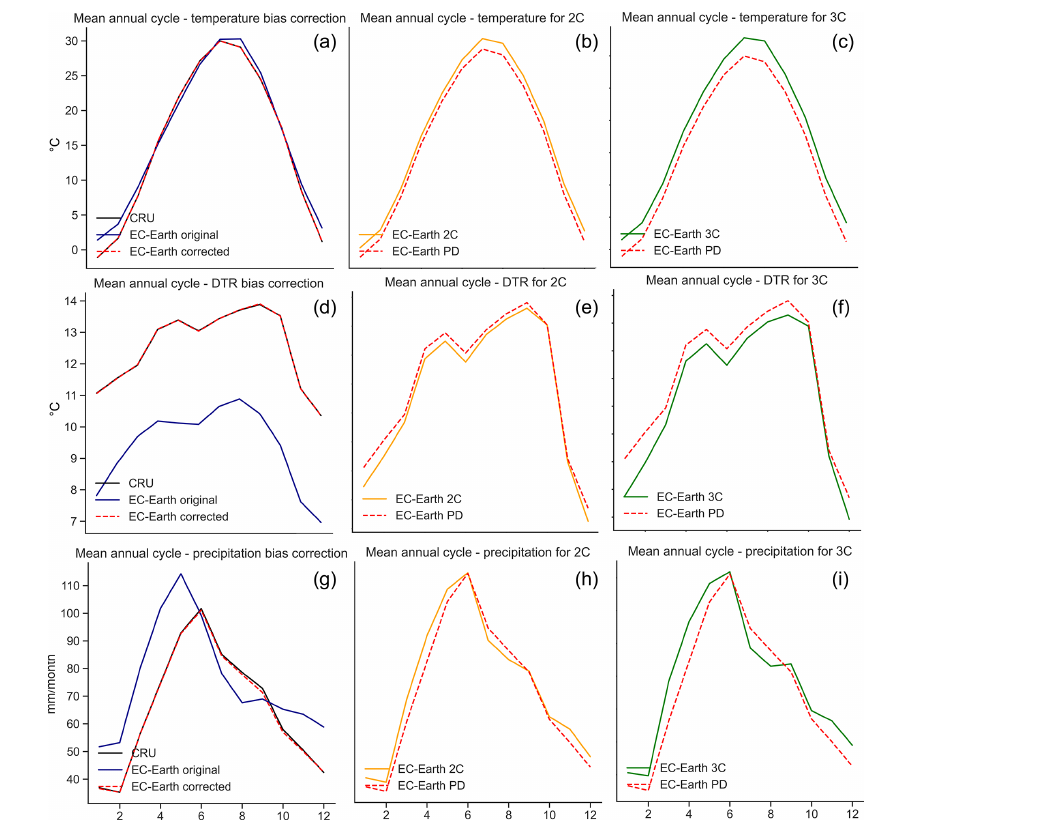
Figure C4. Mean annual cycle for the selected variables: temperature (a, b, c) , DTR (d, e, f) and precipitation (g, h, i) . Panels (a) , (d) , (g) presents the observed data (black), the original EC-Earth PD data (blue) and the EC-Earth after bias correction (dashed red). In panels (b) , (e) , (h) and (c) , (f) , (i) the bias-corrected EC-Earth data for the present-day scenario (PD, dashed red) is then compared with the bias-corrected versions of the 2 ◦ C (2C, b , e , h , orange) and 3 ◦ C (3C, c , f , i , green)